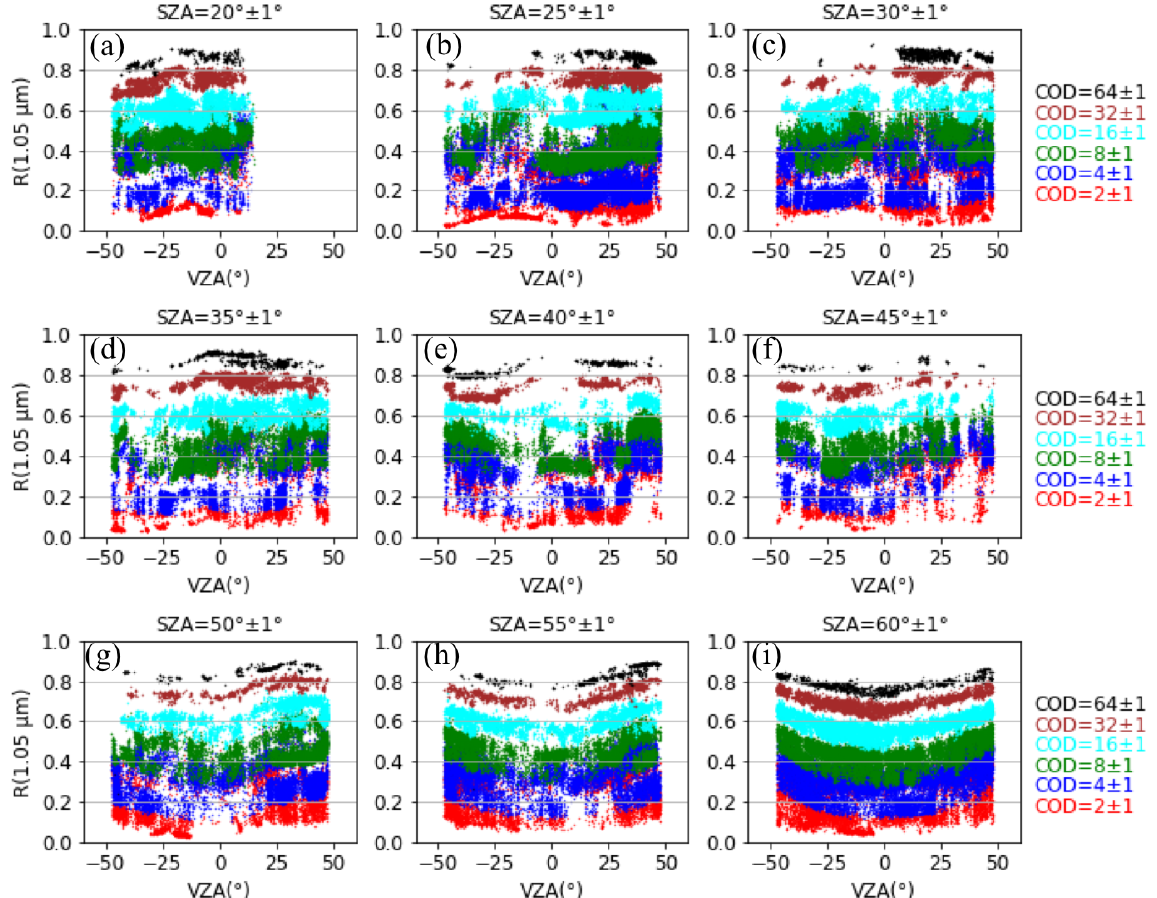
Figure 9. Scatter plots of observed R (1.05µm)–VZA relationships for different COD values of water clouds at different SZA values. The data are for 500 pixels centered on the Chiba observation site in 2020. The negative and positive VZA values represent the forward (relative azimuth angle, RAZ, of > 90 ◦ ) and backward (RAZ < 90 ◦ ) scattering directions,